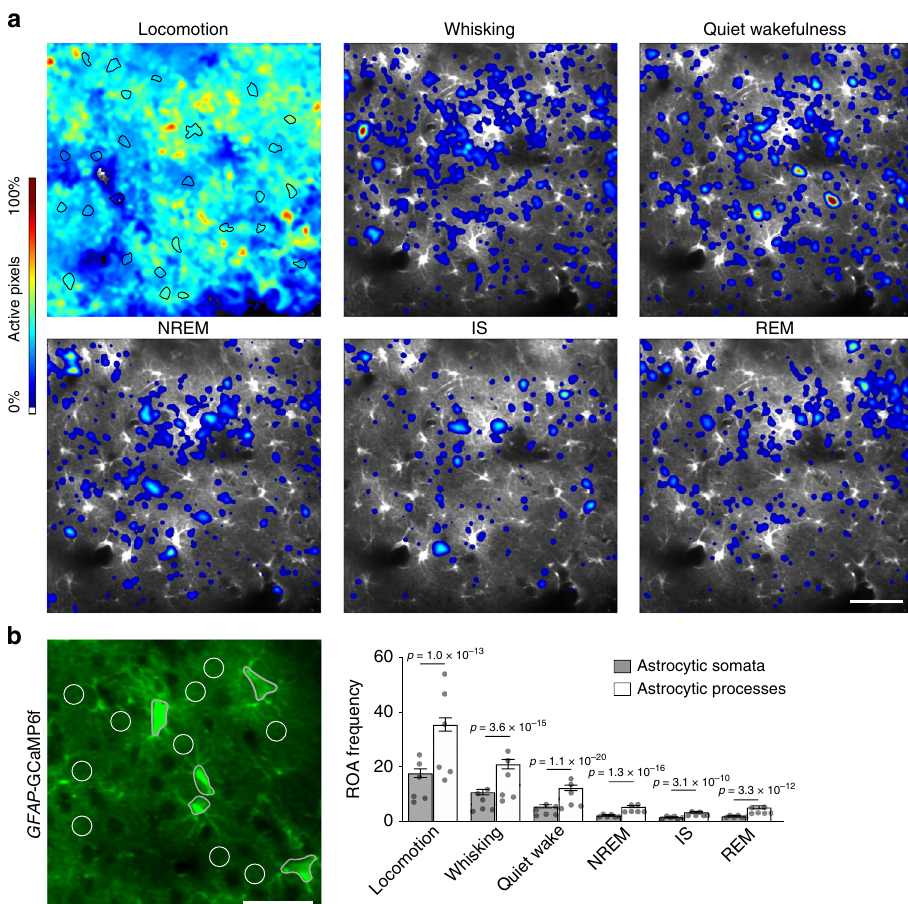
Fig. 3 Astrocytic Ca 2 + signals during sleep are most frequent in processes. a Representative ROA frequency heatmaps showing the localization of Ca 2 + signals during single episodes of locomotion, whisking, quiet wakefulness, NREM sleep, IS sleep, and REM sleep states. Astrocytic somata outlined in black in the locomotion image. Scale bar 50 μ m. b Representative image of GFAP -GCaMP6f fl uorescence in astrocytes with ROIs over astrocytic somata (black) and neuropil, containing astrocytic processes (white circles of 10 μ m in diameter) (left). Scale bar 30 μ m. ROA frequency, expressed as number of ROAs per ROI per minute, in astrocyte somata and processes from ROIs shown in left across sleep-wake states (right). Data represented as estimates ± SE and p - values (two-sided test, no adjustment for multiple comparisons) derived from linear mixed effects models statistics, n = 6 mice, 247 trials. For details on statistical analyses, see “ Methods. ” See also Supplementary Fig.